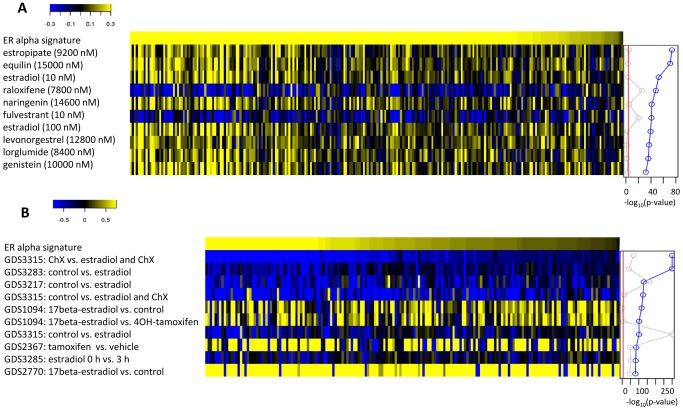
Mining for ERα activity in transcriptional perturbation signatures and disease-related gene expression profiles.Differential gene expression levels (on log2 scale) for ERα targets with statistically significant ERα TREG concordance scores (p-value<0.01) in transcriptional signatures with the highest evidence of ERα regulatory activity. The evidence of ERα regulatory activity consisted of the statistical significance of the GRS concordance between ERα TREG signature and the differential gene expression profile (blue line to the right of the heatmap). The ERα signature (top row in each heatmap) represents the differential expression levels in the E2+CHX profile. A) Top 10 perturbation signatures with highest evidence of ERα activity among differential gene expression profiles of small drug perturbations in the Connectivity Map dataset. B) Top 10 perturbation signatures with highest evidence of ERα activity among differential gene expression profiles of between different sample types in GEO datasets.